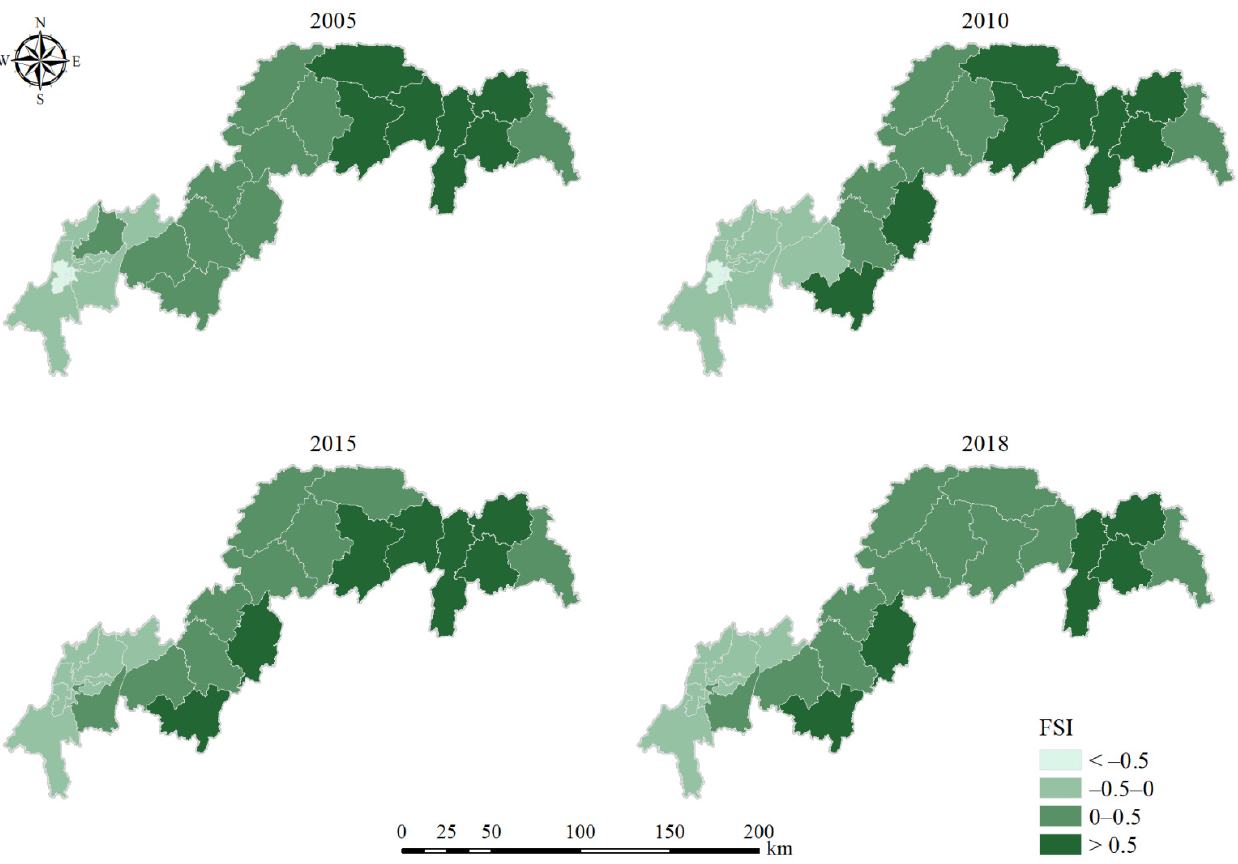
Figure 12. Spatiotemporal distribution of FSI in the Three Gorges Reservoir Area from 2005 to 2018. On the spatial scale, the multi-year average FSI of each district and county in the TGRA fluctuates between − 0.49 and 0.74 (Figure 13). The high FSI zones are mainly concentrated in the key ecological function areas. In contrast, the low FSI areas are mainly located in the Reservoir tail zones in the key development areas. From 2005 to 2018, Beibei, Jiangbei, Nanan, Shapingba, Dadukou, and Jiulongpo districts have a shortage of WSSs, with their multi-year average FSI ranging from − 0.49 to 0.13. The primary reason for the low FSI is that the districts mentioned above are low-value water yield regions, accounting for only 3.9% of the total annual water yield of the entire TGRA, with a limited urban water supply capacity. At the same time, the districts mentioned above are located in the core urban region of Chongqing, with rapid economic development and urbanization, and construction land accounts for 32.21% of the entire TGRA. For many years, the total gross industrial production and urban domestic water consumption reached 39.94% and 41.67% of the entire TGRA; thus, the demand for WSSs is